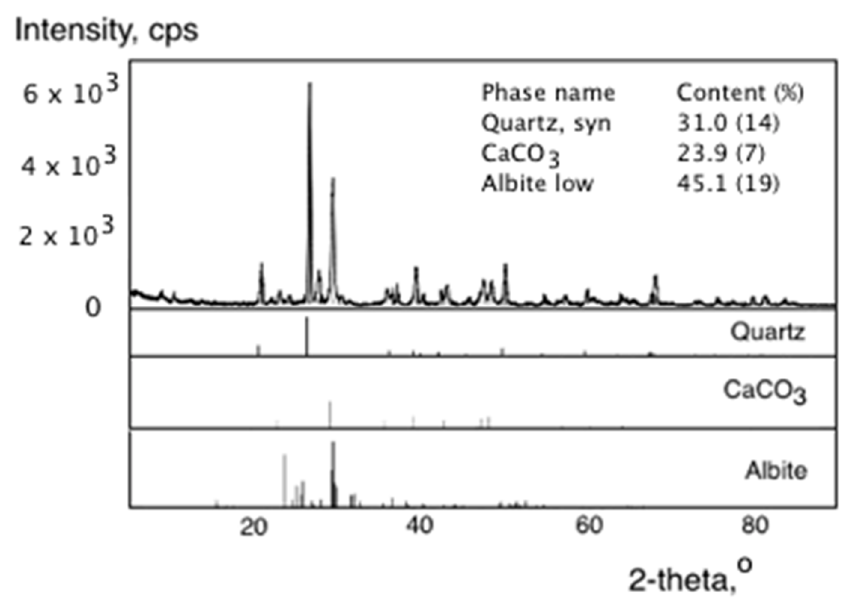
Figure 3. XRD diagram of the white part of the fresco with Rietveld processing.